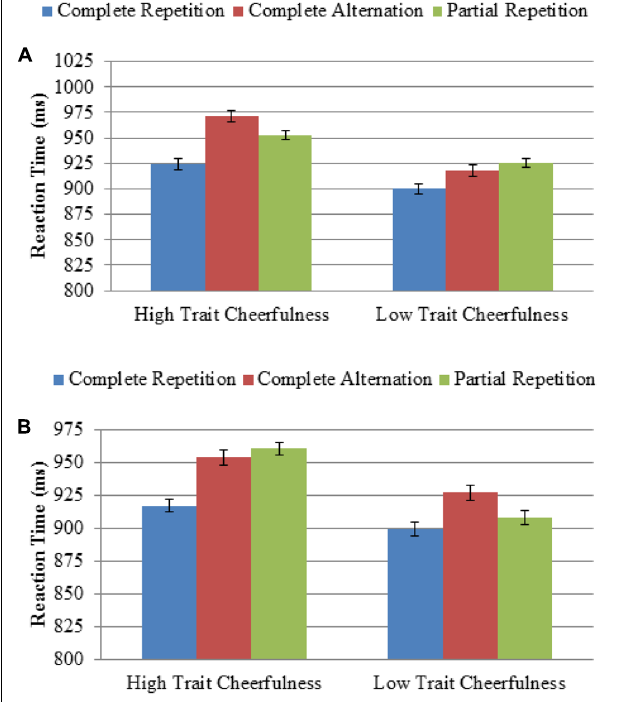
FIGURE 3 | Effect of attribute repetition as a function of the trait cheerfulness group for: (A) Study 1; and (B) Study 2, preparation part. Both graphs reveal that participants with high trait cheerfulness showed a higher repetition effect than those with low trait cheerfulness, measured as an increased difference when all attributes were repeated compared to no repetition or partial repetition. The error bars represent the standard error of the mean, with variability between participants removed by means of Coussineau’s